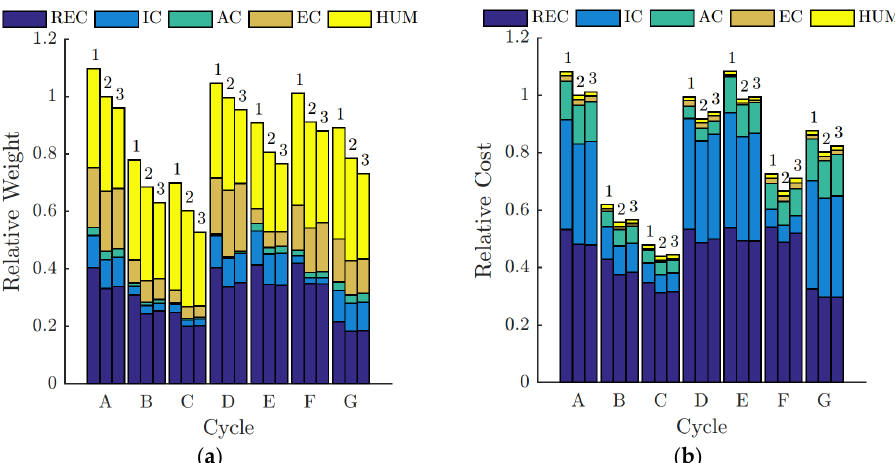
Figure 9. ( a ) break down of heat exchanger total relative weight; and ( b ) break down of heat exchanger total relative cost. (Bar 1) OPR = 30 & ∆ T ps = 5 K; (Bar 2) OPR = 40 & ∆ T ps = 5 K; (Bar 3) OPR = 40 & ∆ T ps = 15